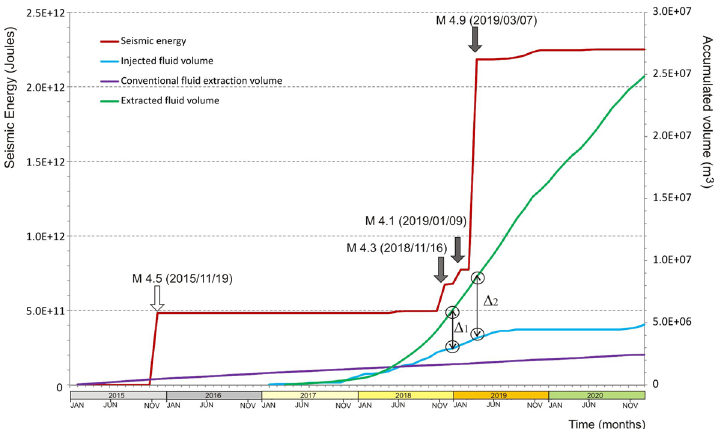
Figure 4. Accumulated seismic energy released (in Joules) recorded by INPRES between 2015 and 2020, versus different underground operations within the Neuquén basin study area (in m 3 ). Blue and green lines show injected and extracted fluid volume, respectively, using unconventional methods. Purple line shows extracted fluid volume using conventional methods. The production data used for this figure are the same used in Fig.